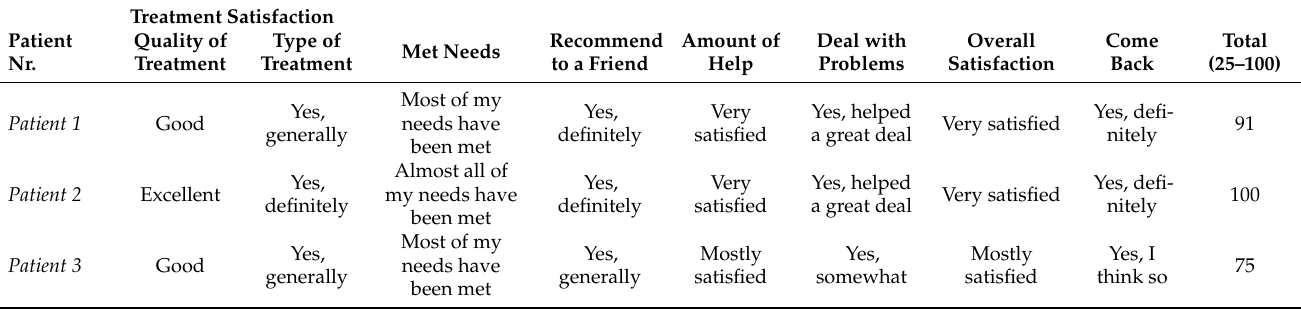
Table 5. Treatment satisfaction as measured with the